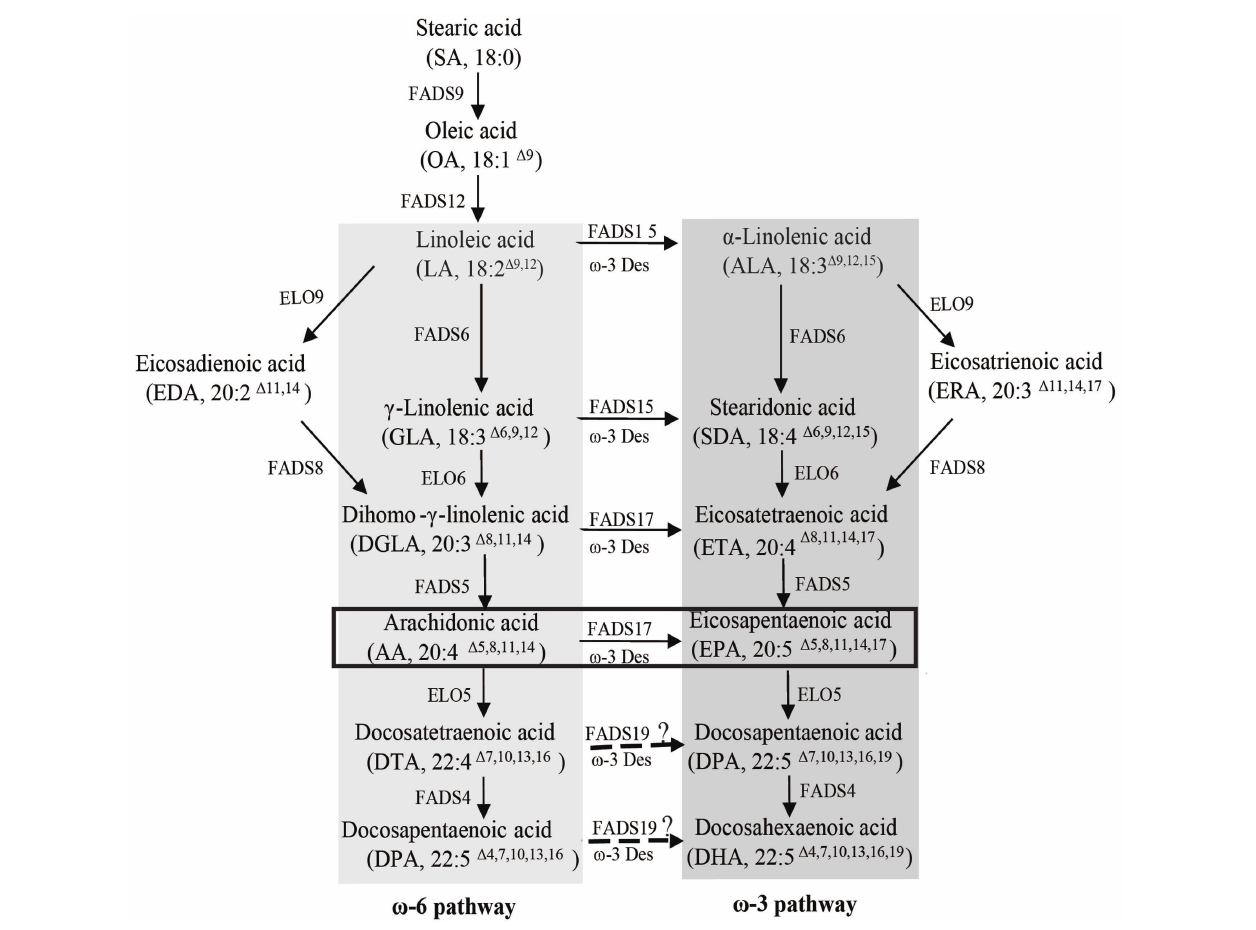
FigUre 1 | Fatty acid synthesis in Mortierella alpina . The ω -6 and ω -3 pathways are highlighted by dark gray and light gray boxes, respectively. The ω -3 desaturase oPaFADS17 plays a major role in the pathway highlighted by the black box. FADS9, delta 9 desaturase; ELO9, delta 9 elongase; FADS12, delta 12 desaturase; FADS6, delta 6 desaturase; FADS15, delta 15 desaturase; ELO6, delta 6 elongase; FADS8, delta 8 desaturase; FADS5, delta 5 desaturase; FADS17, delta 17 desaturase; ELO5, delta 5 elongase; FADS19, delta 19 desaturase; FADS4, delta 4 desaturase; ELO7, delta 7